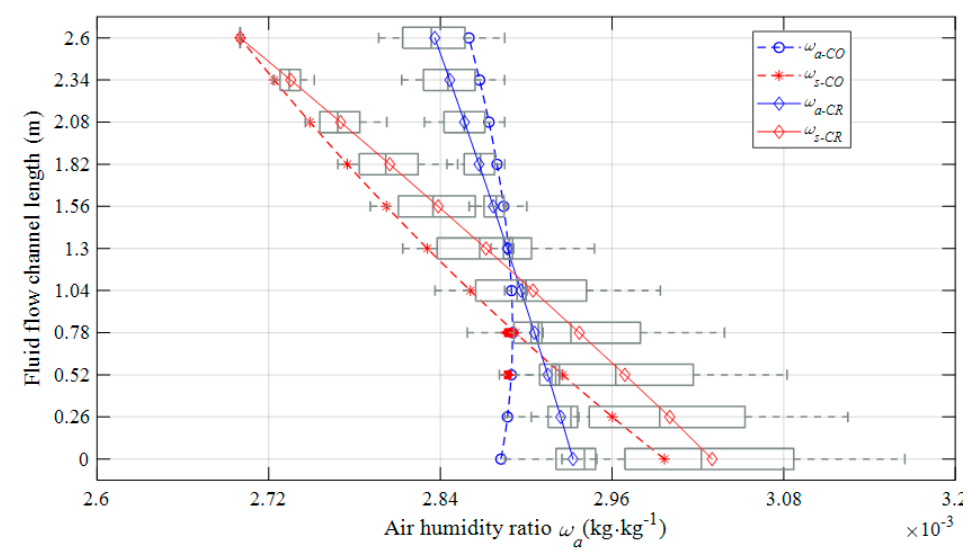
Figure 20. Variation of ω a and ω s along the fluid flow channel length—RH = 50%.